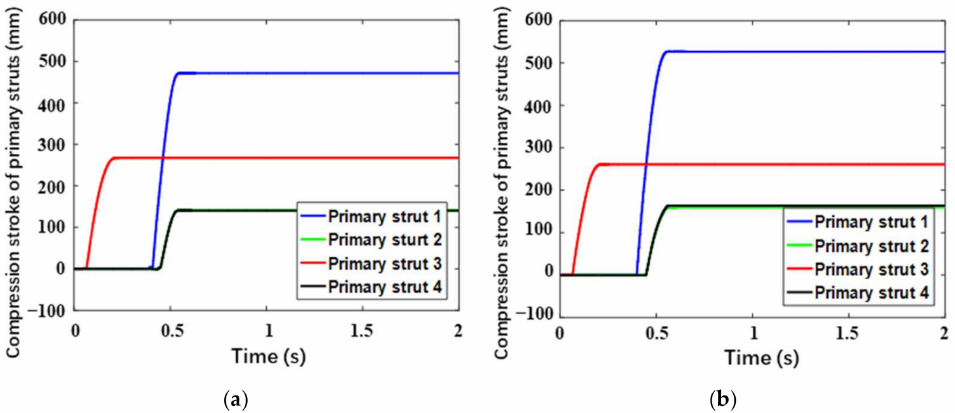
Figure 13. Compression stroke of primary struts versus time for ( a ) buckypaper-buffering lander and ( b ) aluminum honeycomb-buffering lander.